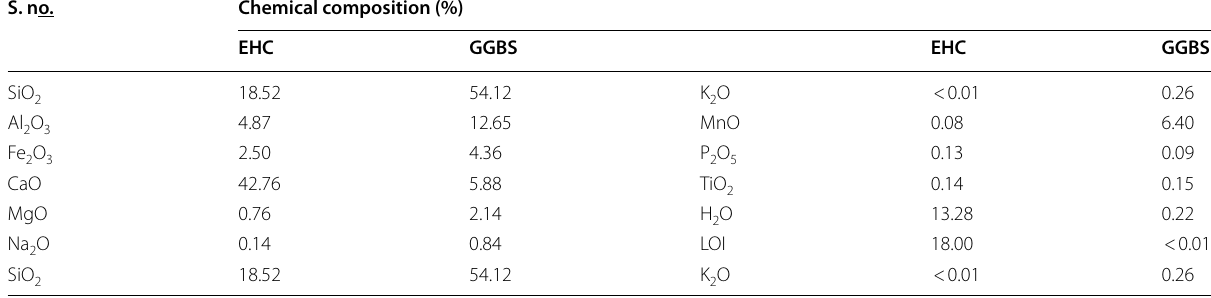
Table 1 Chemical composition of EHC and GGBS S. no.